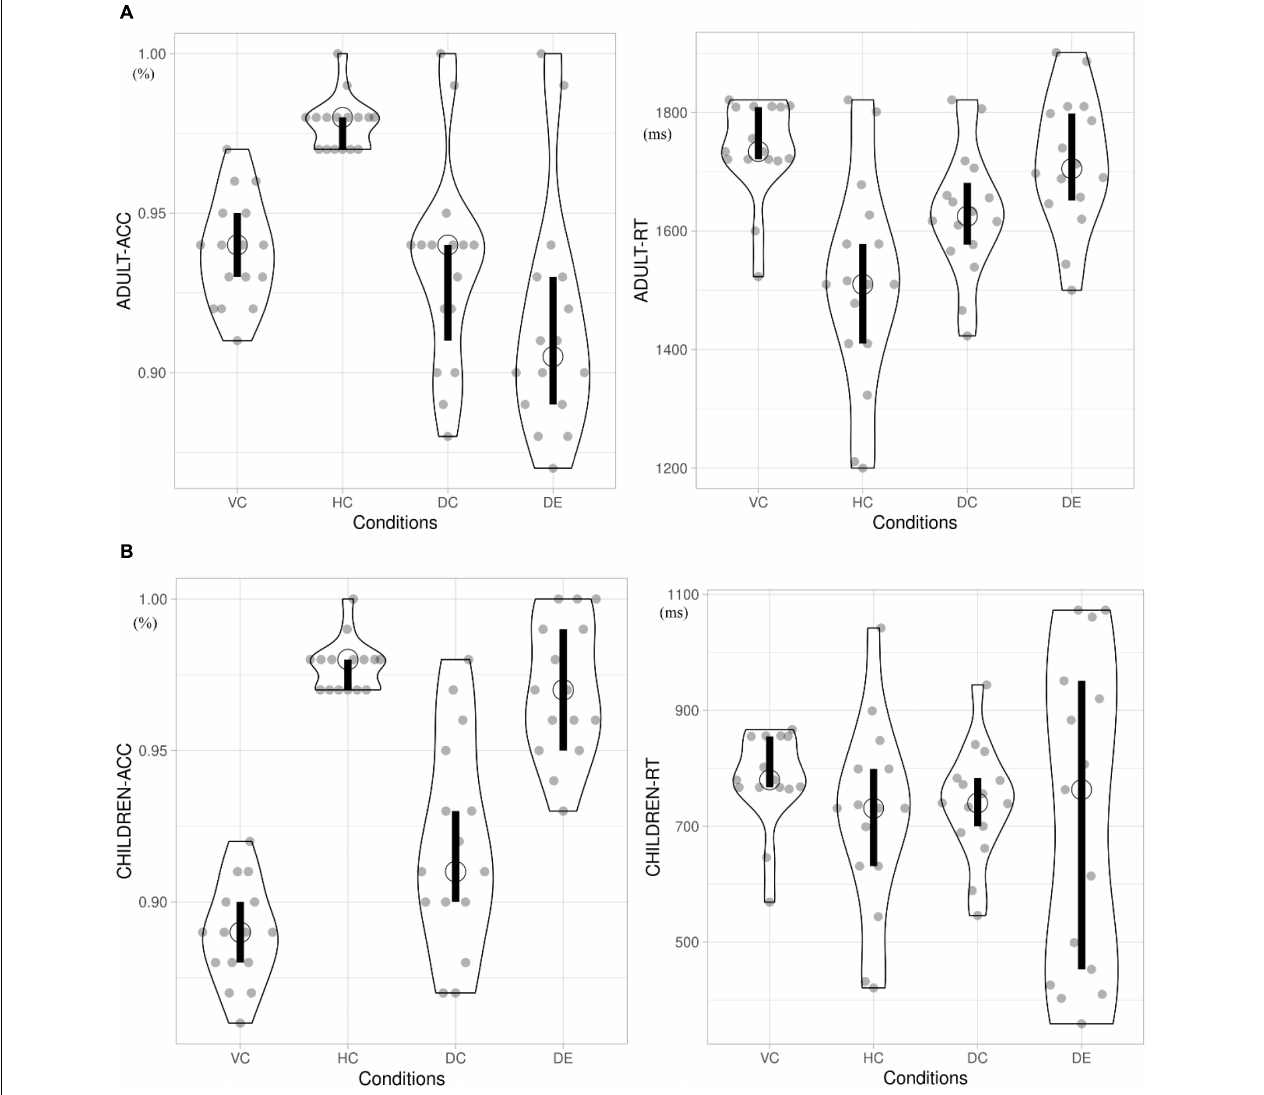
FIGURE 2 | (A) Behavioral data of adults. Open circle indicates the median in each condition. Vertical bar indicates the 95% confidence interval for each median determined by bootstrapping. ACC, accuracy; RT, response time; VC, viewing Chinese; HC, handwriting Chinese; DC, drawing followed by Chinese recognition; DE, drawing followed by English recognition. (B) Behavioral data of children. Open circle indicates the median in each condition. Vertical bar indicates the 95% confidence interval for each median determined by